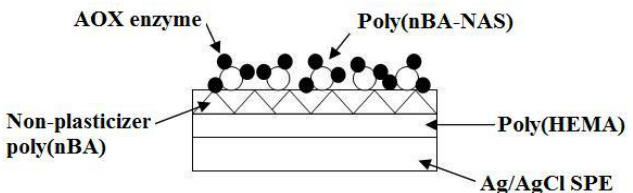
Figure 1. Potentiometric formaldehyde biosensor based on AOX-poly(nBA-NAS) deposited on membranes on a Ag/AgCl